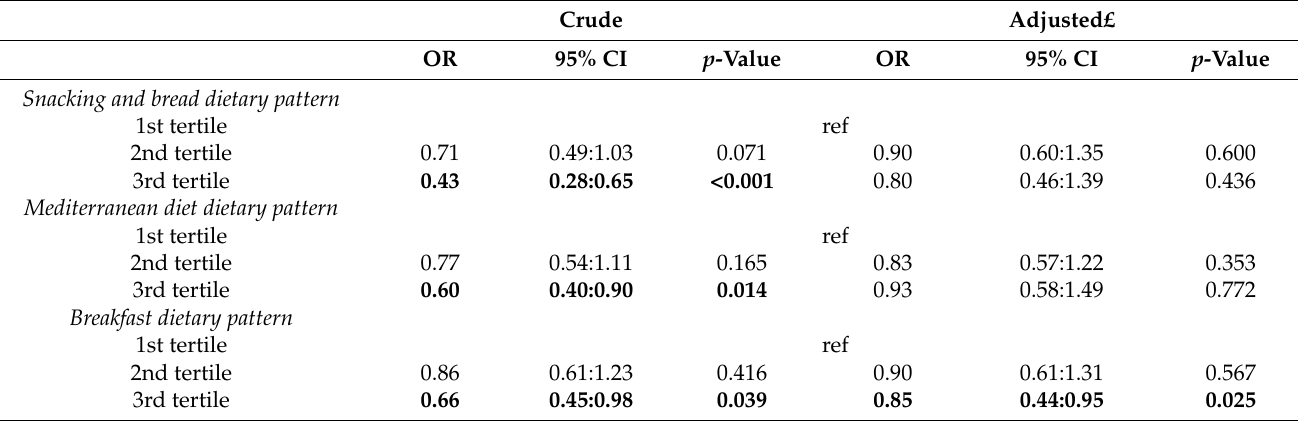
Table 3. Association between the tertiles of dietary patterns and overweight/obesity in the boys. HELENA study. Crude Adjusted£ OR 95% CI p -Value OR 95% CI p -Value Snacking and bread dietary pattern